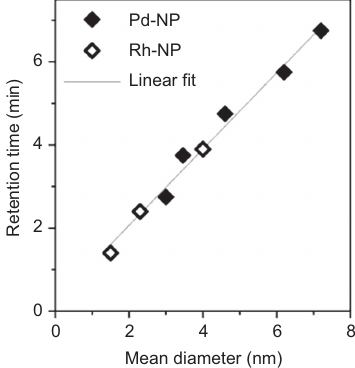
Figure 6 Plot of the retention time vs. the mean particle diameter (TEM) for the C -amine-stabilized Pd and Rh NP 12